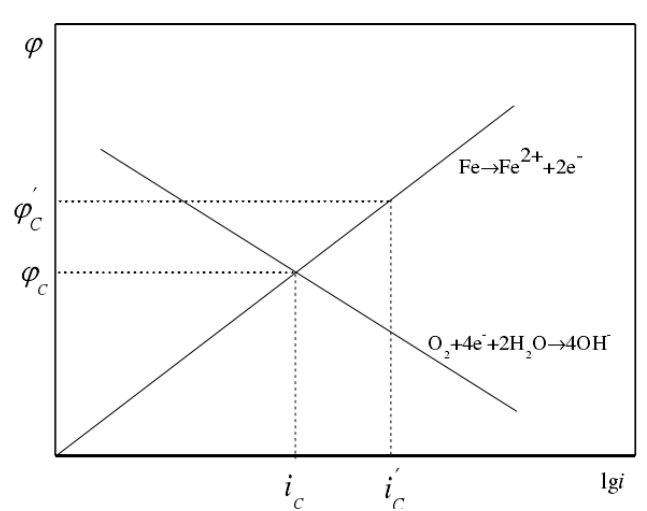
Figure 6. Schematic diagram of the polarization curve of steel with DC stray current .